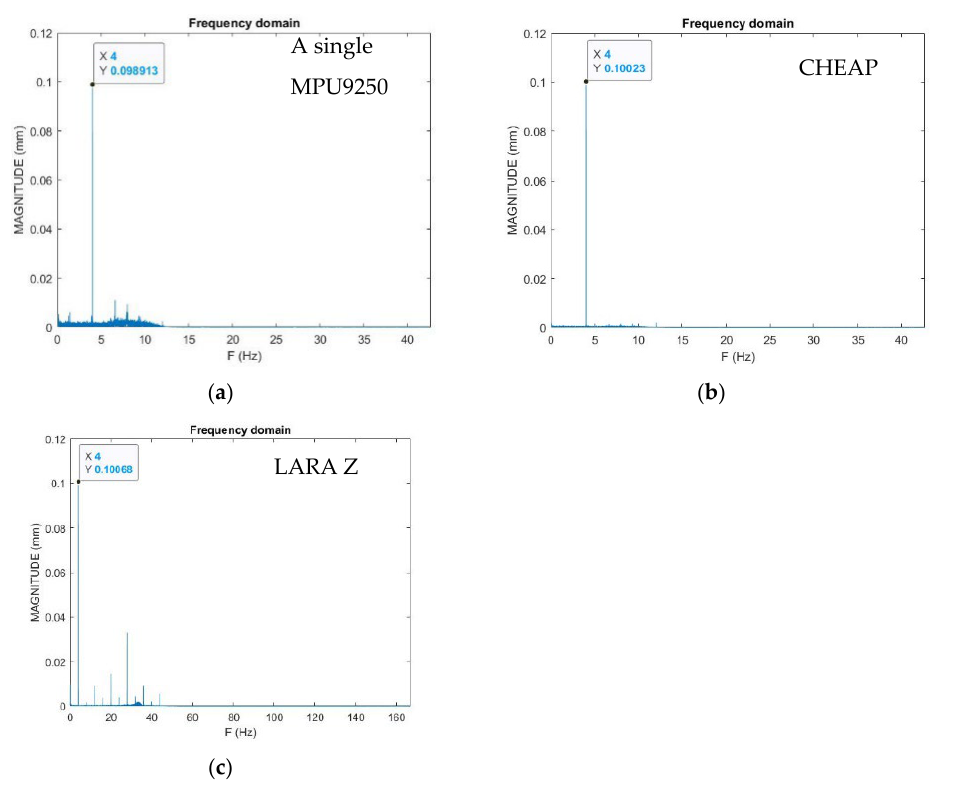
Figure 7. Displacement report of the accelerometers: ( a ) MPU9250, ( b ) CHEAP, and ( c ) LARA.